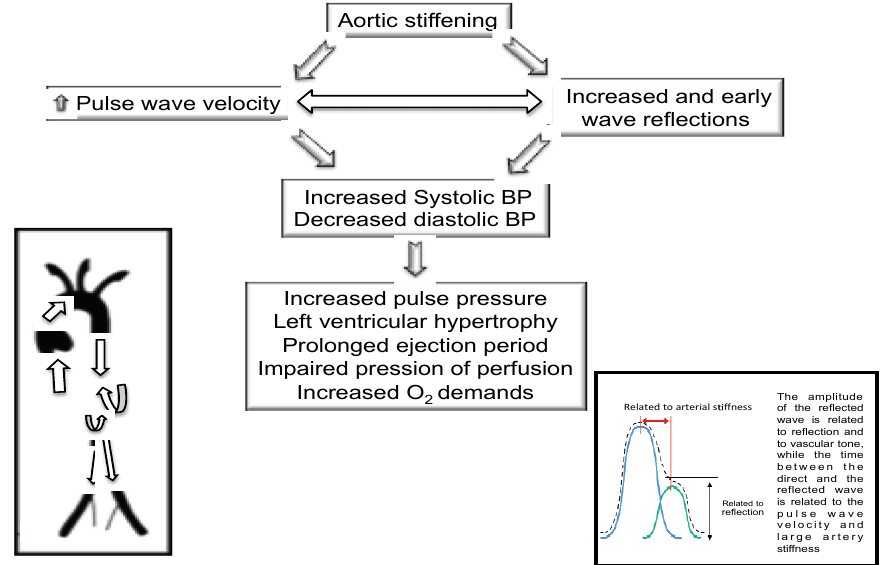
Figure 5. Arterial stiffness and wave reflections are known to play a fundamental role in cardiovascular health and disease. Indeed, in interplay with left ventricular ejection and the elastic properties of the aorta, wave reflections could specifically increase central pulse pressure, a recognized predictor of cardiovascular risk. These changes are attributed to the timing and amplitude of pulse wave reflections from peripheral reflecting sites, where